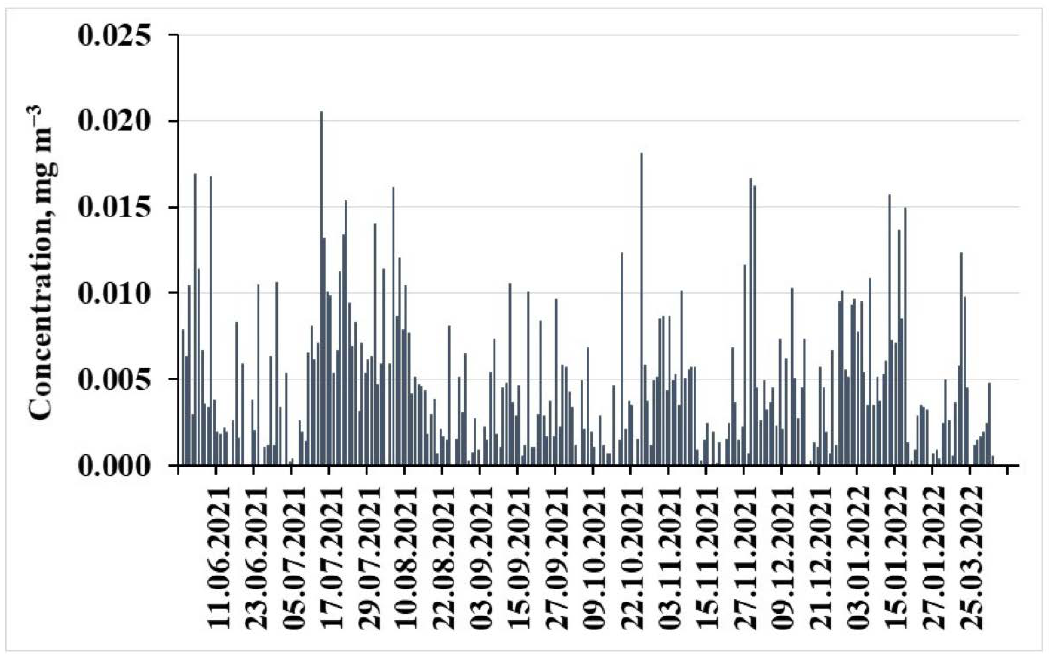
Figure 4. Variations of elemental carbon concentrations in the atmosphere in